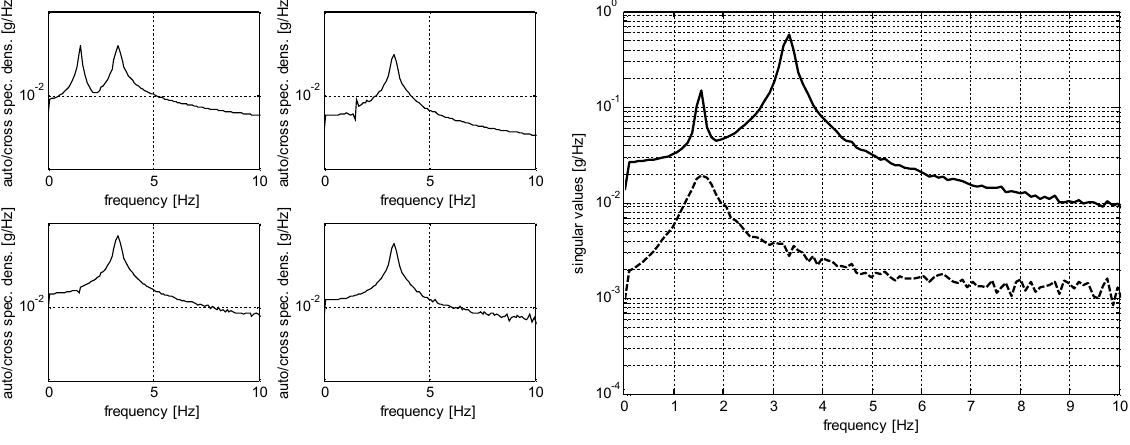
Fig. 13. Auto and cross spectral densities and singular values of the numerical